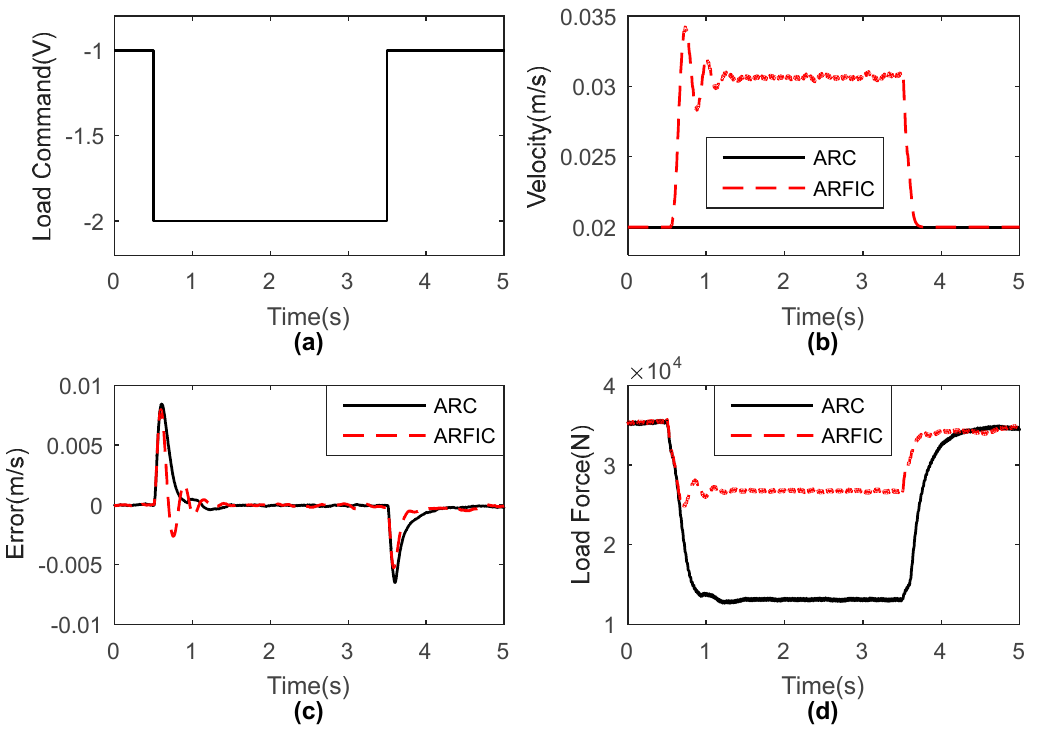
Figure 10. Tracking performance with a 0.02 m/s velocity command and − 1 V ∼ − 2 V ∼ − 1 V load command: ( a ) load command; ( b ) velocity commands; ( c ) velocity tracking errors; ( d ) load forces.